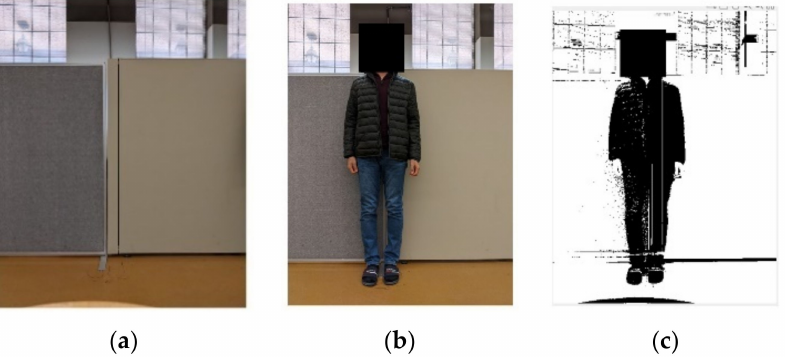
Figure 5. Background removal process. ( a ) Background image, ( b ) image with the subject, and ( c ) the subject’s image with the background removed.